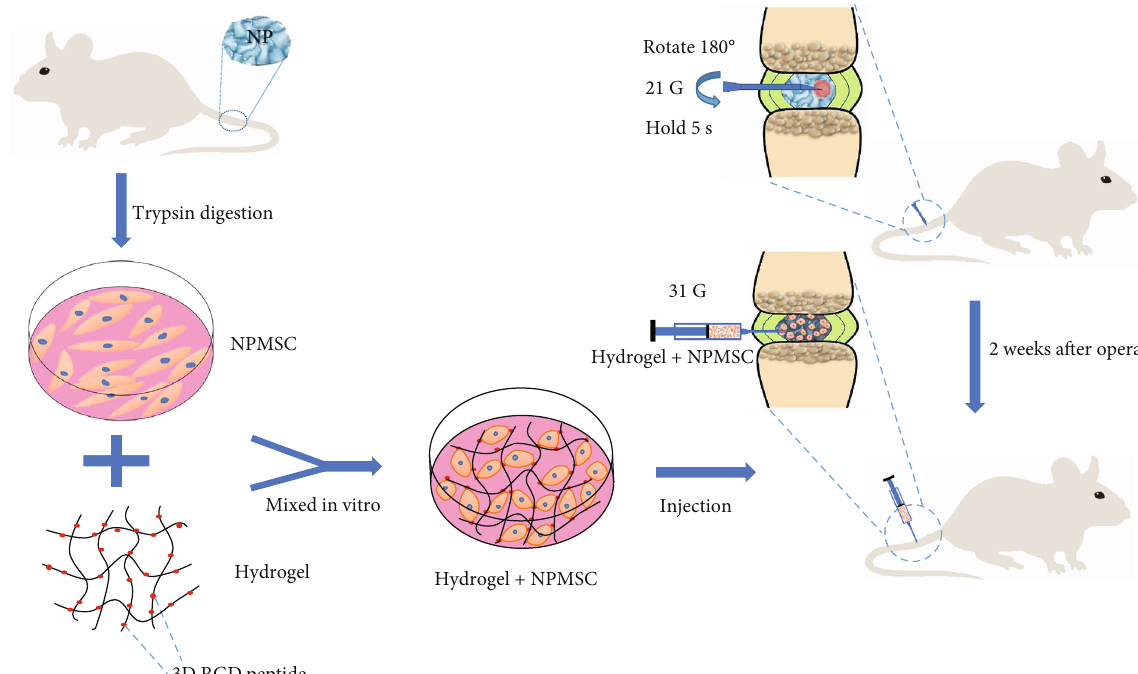
Figure 1: Schematic of the basic process of the present study. NPMSC were isolated from the coccygeal IVD of SD rats, and ampli fi cation was performed in vitro. After IDD model induction by a 21G needle, injectable hydrogel-loaded NPMSC was transplanted into the degenerated NP by a